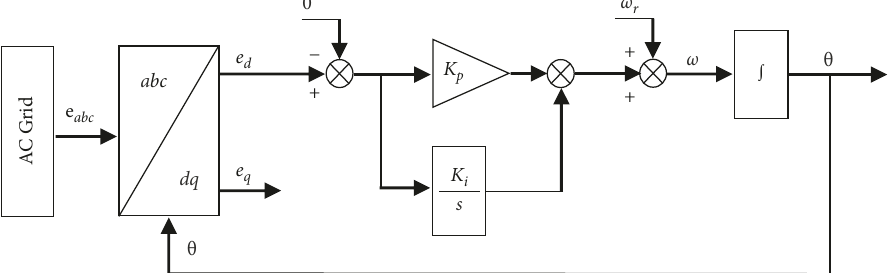
Figure 6: Structure of conventional phase-locked loop.